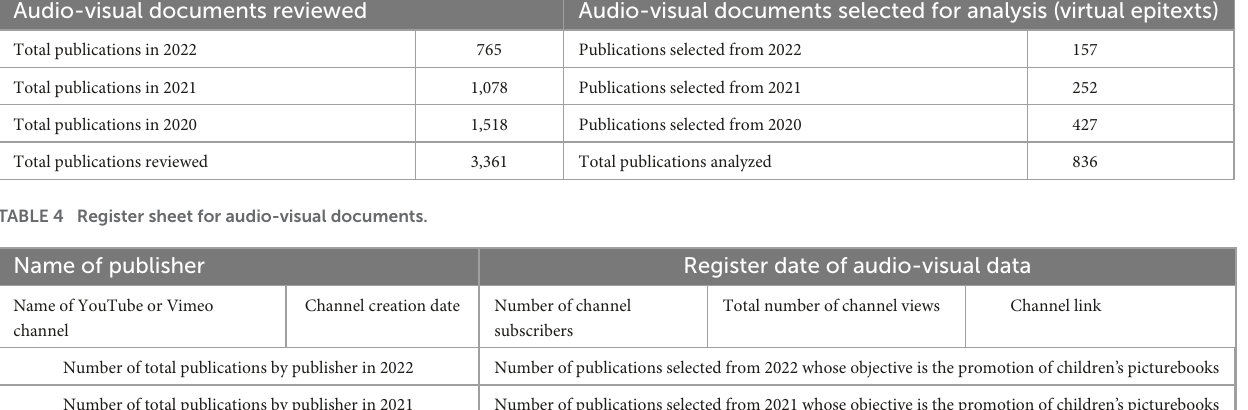
TABLE 3 Audio-visual documents reviewed and documents selected. Audio-visual documents reviewed